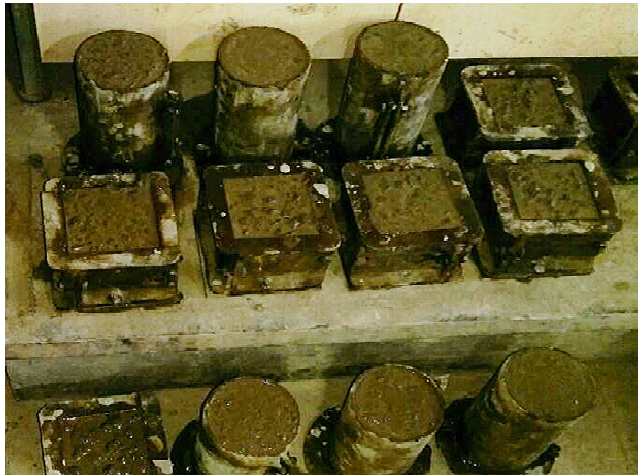
Figure 1. Fresh concrete in cubic and cylindrical molds.